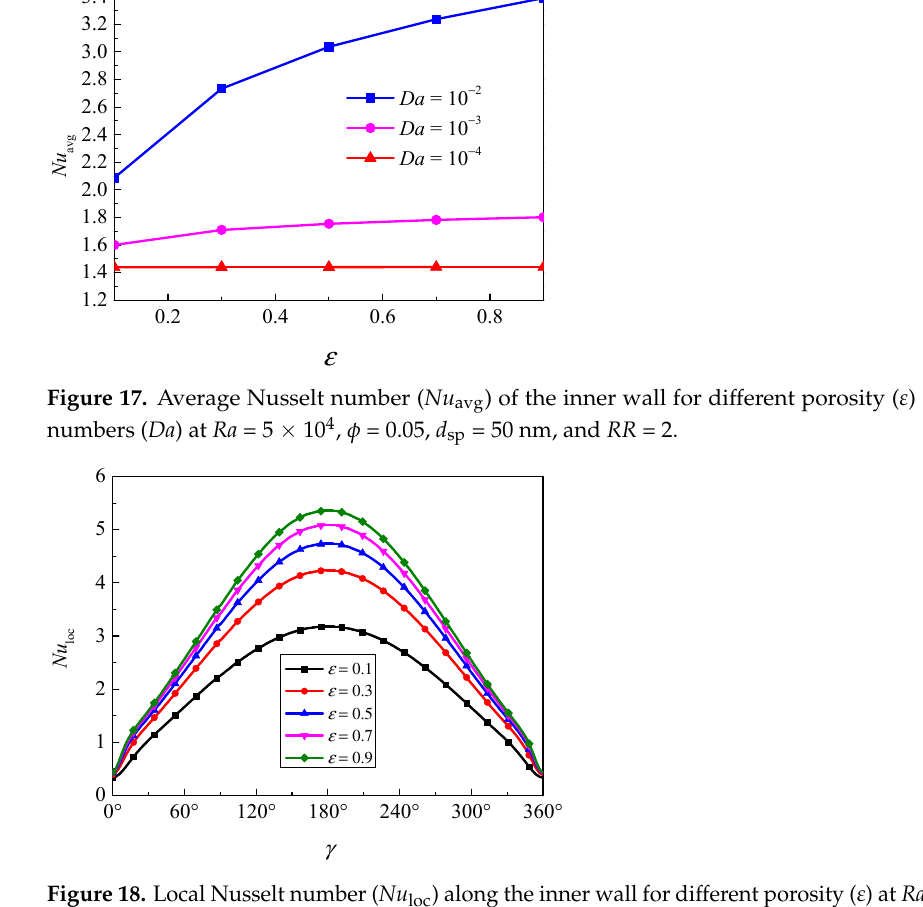
Figure 18. Local Nusselt number ( Nu loc ) along the inner wall for different porosity ( ε ) at Ra = 5 × 10 4 , Da = 10 − 2 , ϕ = 0.05, d sp = 50 nm, and RR = 2.